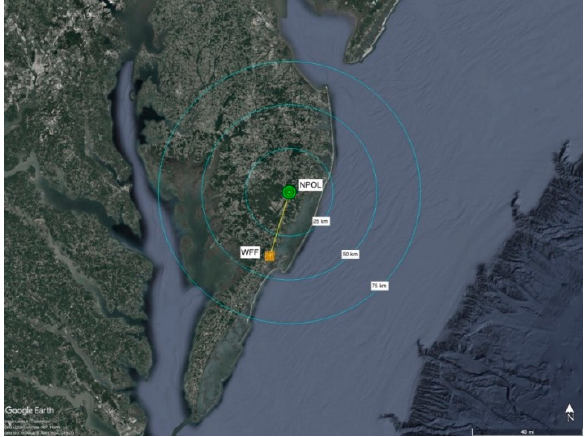
Figure 1. NASA Polarimetric (NPOL) radar and the disdrometer location.